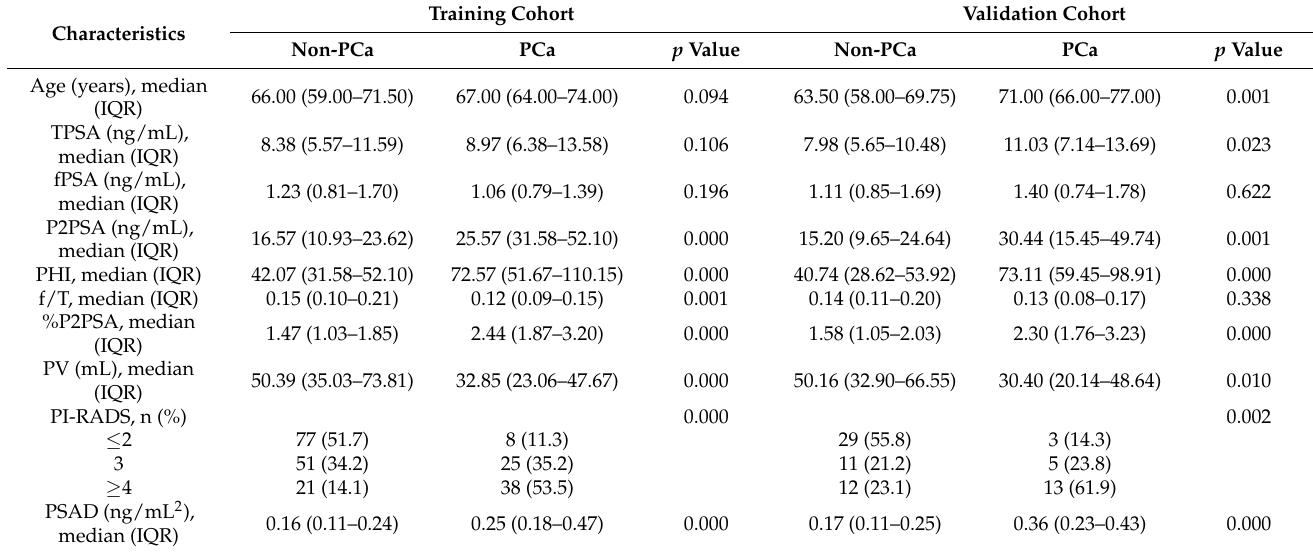
Table 3. Patient characteristics in training and validation cohorts with and without